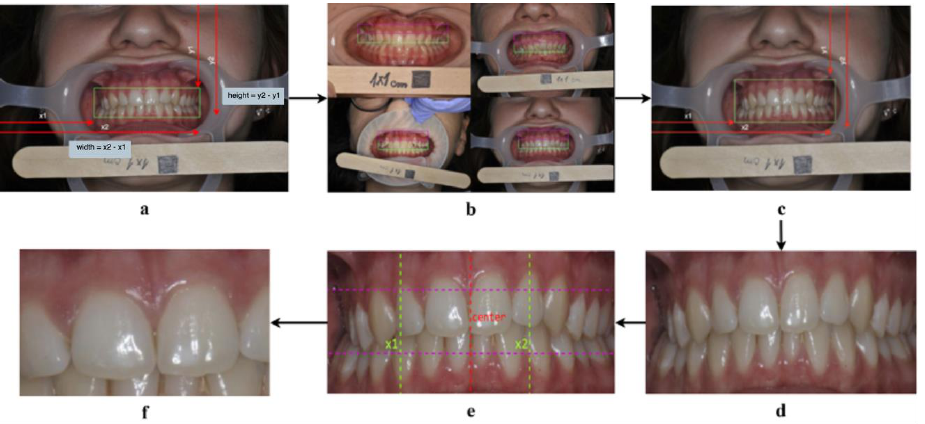
Figure 1 . Architecture of the Faster R-CNN model . Figure 1. Architecture of the Faster R-CNN model. Int. J. Environ. Res. Public Health 2020 , 17 ,